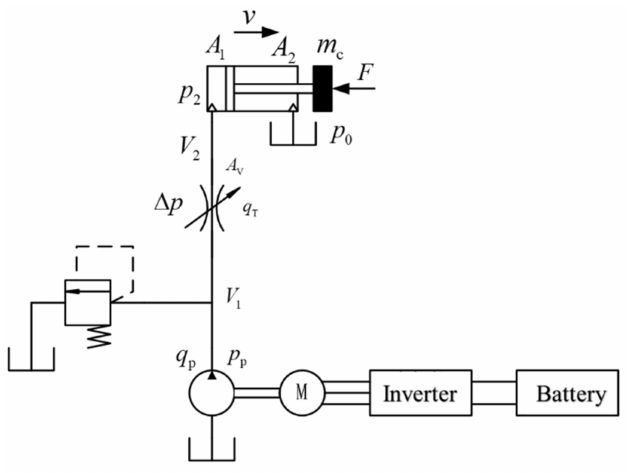
Figure 4. Simplified schematic diagram of the